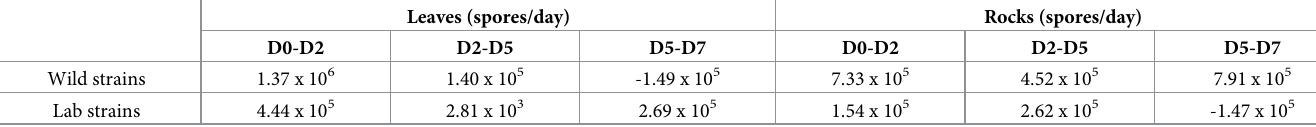
Table 1. The comparison of sporulation rates between laboratory-adapted and wild strains at each time points on leaf and rock surfaces. Leaves